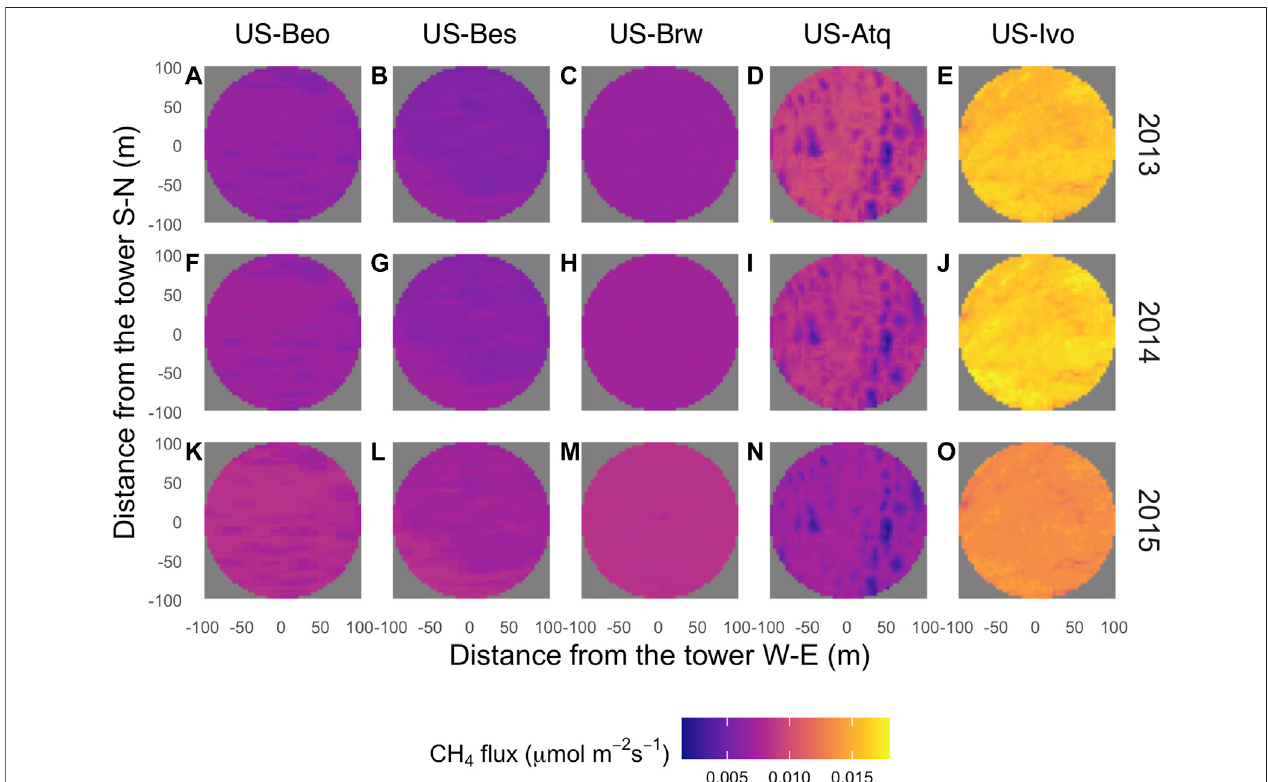
FIGURE 4 | Spatial patterns of upscaled CH 4 emission rates based on the homogeneous footprint (HF) algorithm in an area of 200 m × 200 m during a period of 2013 – 2015 for (A, F, K) US-Beo, (B, G, L) US-Bes, (C, H, M) US-Brw, (D, I, N) US-Atq, and (E, J, O) US-Ivo.